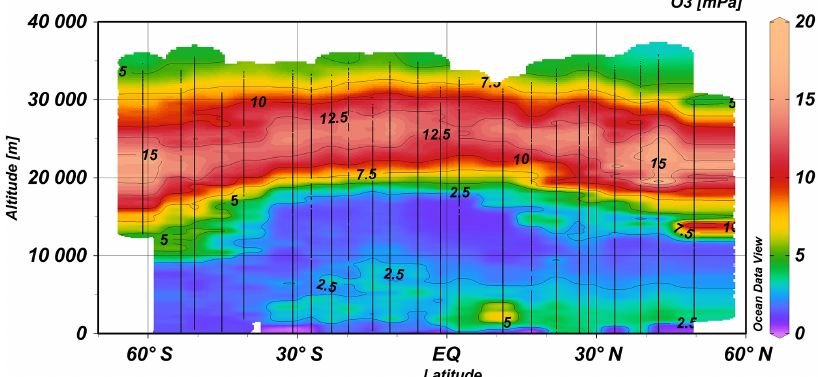
Figure 5. Meridional-height section of ozone (O 3 in mPa) from POLARSTERN cruise ANT-XVII (14 December 1999 to 20 January 2000). The lines represent the actual launches, the data were then interpolated to obtain this figure.